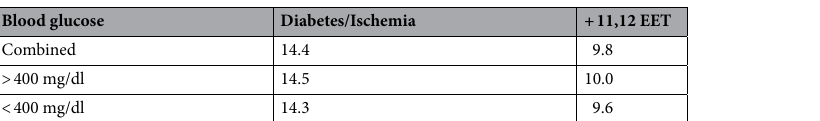
Blood glucose Diabetes/Ischemia + 11,12 EET